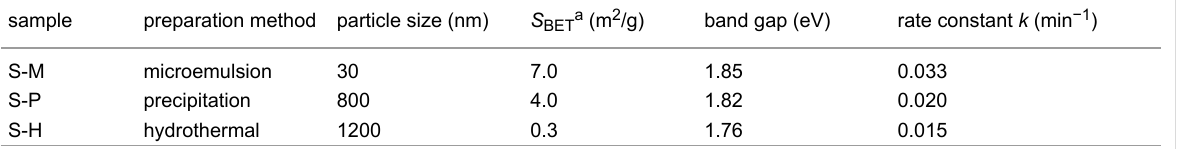
Table 1: Physical properties and photocatalytic performance of as-prepared samples. sample